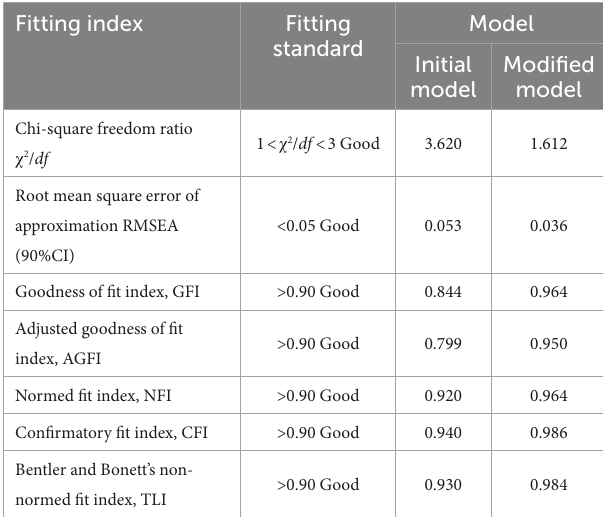
TABLE 5 Fitting results of the structural equation